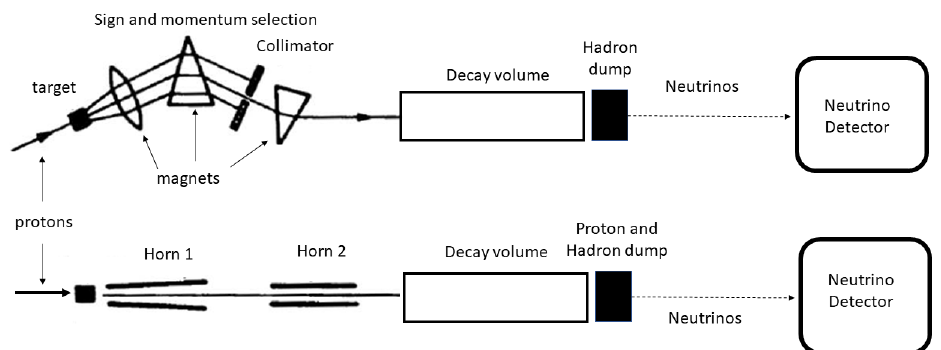
Figure 1. ( top ) A typical layout for a narrow-band beam. After the target, a set of quadrupoles, dipoles and collimators (slits) selects the sign and momentum and steers the secondaries toward the decay volume. All charged particles but neutrinos are stopped at the hadron dump located before the neutrino detector. The baseline of the facility is the target to neutrino detector distance. ( bottom ) A wide-band beam where the focusing and momentum selection is performed by a set of horns (in the figure, “Horn 1” and “Horn 2”). The second horn is often called “reflector”. Note that a horn can be inserted also in a narrow-band beam, generally between the target and the first